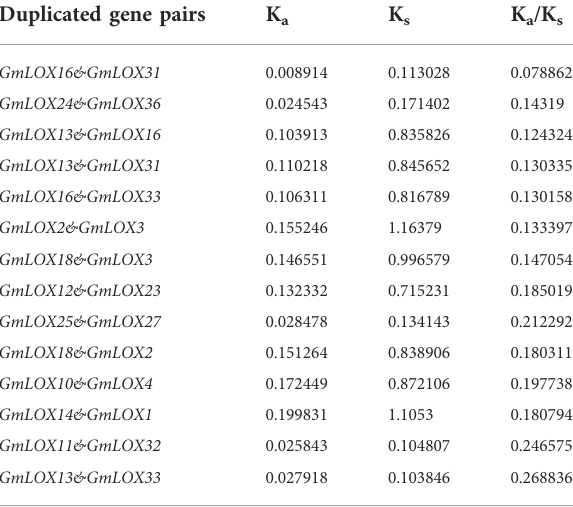
TABLE 2 Estimation of the K a /K s ratio of homologous gene pairs in Zhonghuang 13. Duplicated gene